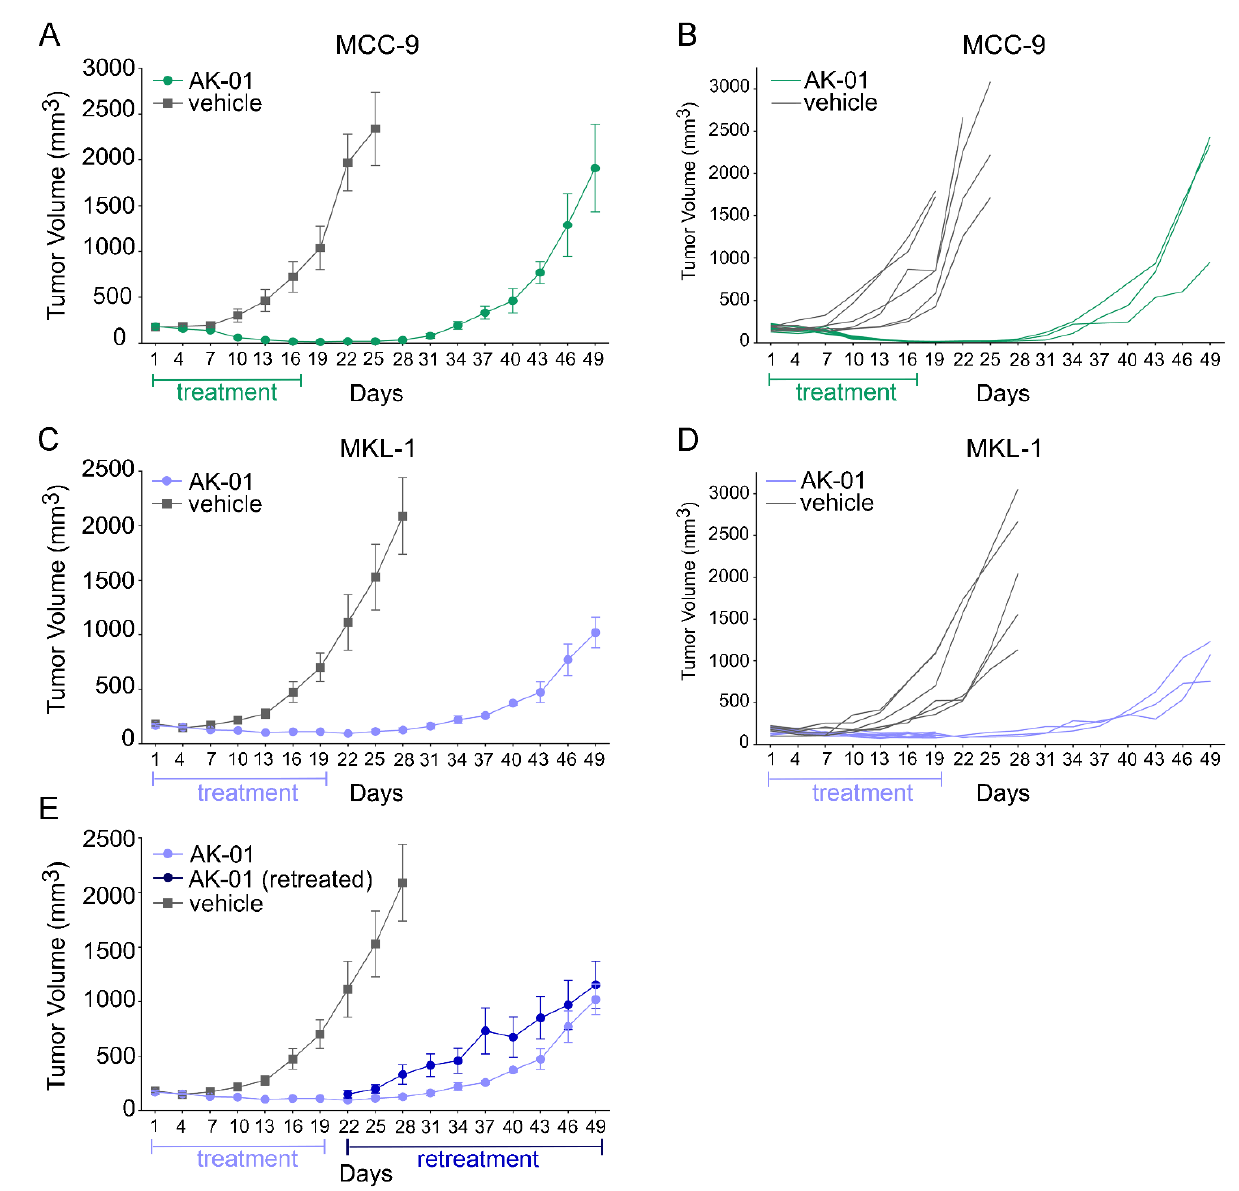
Figure 4. AK-01 mitigates tumor growth of MCC xenografts in NSG mice. NSG mice bearing MCC-9 ( A , B ) or MKL-1 ( C – E ) xenograft tumors were treated with vehicle or 50 mg/kg AK-01 twice daily by oral gavage for 16 or 19 days, respectively. After randomization, tumor volume was monitored 3 × weekly and presented as mean volume ± SEM ( A , C , E ) or individually ( B , D ). In both MCC-9 and MKL-1 xenograft cohorts, three AK-01 treated mice were observed for tumor relapse (days 16–49 and days 19–49, respectively) after discontinuing treatment. For MKL-1, three AK-01 treated mice resumed treatment upon tumor relapse ( E ; retreated mice represented in dark blue).